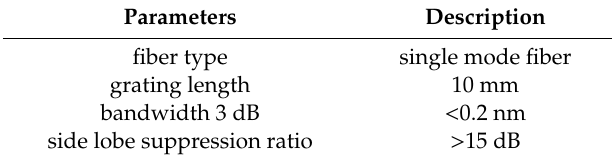
Table 2. The detailed parameters of the fiber Bragg grating (FBG) sensing points.